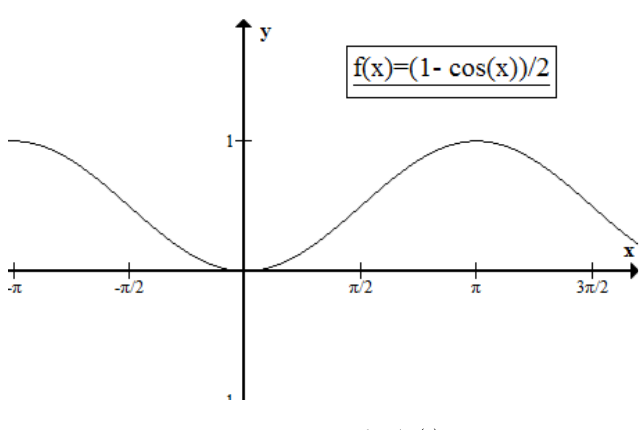
Figure 8. Image for h r ( i ) .